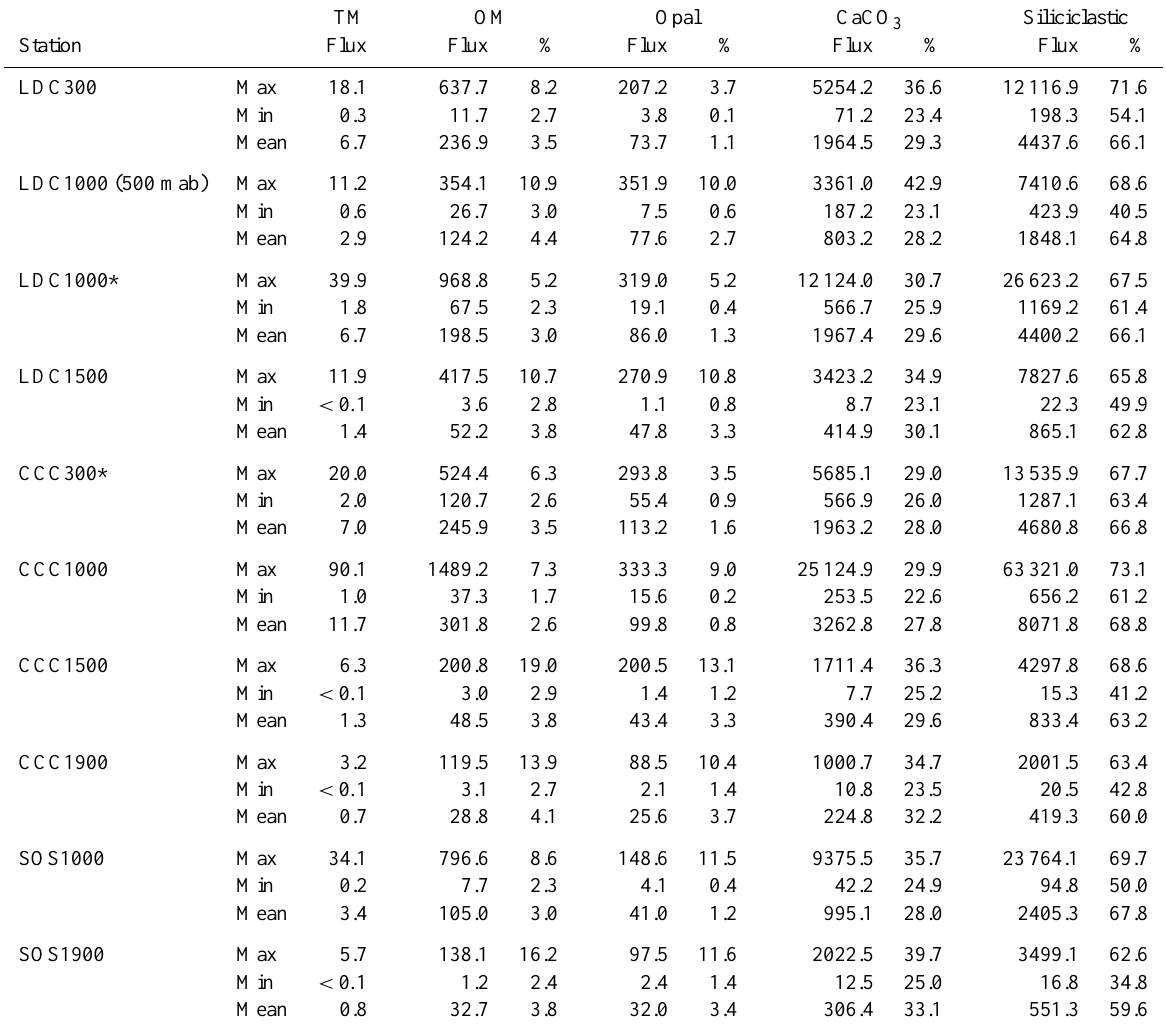
Table 1. Total mass (TM) flux (gm − 2 d − 1 ) , main components (OM, opal, CaCO 3 and siliciclasts) flux (mgm − 2 d − 1 ) and content (%) along the Lacaze-Duthiers Canyon, Cap de Creus Canyon and Southern Open Slope transects. Statistics presented are mean, maximum (Max)